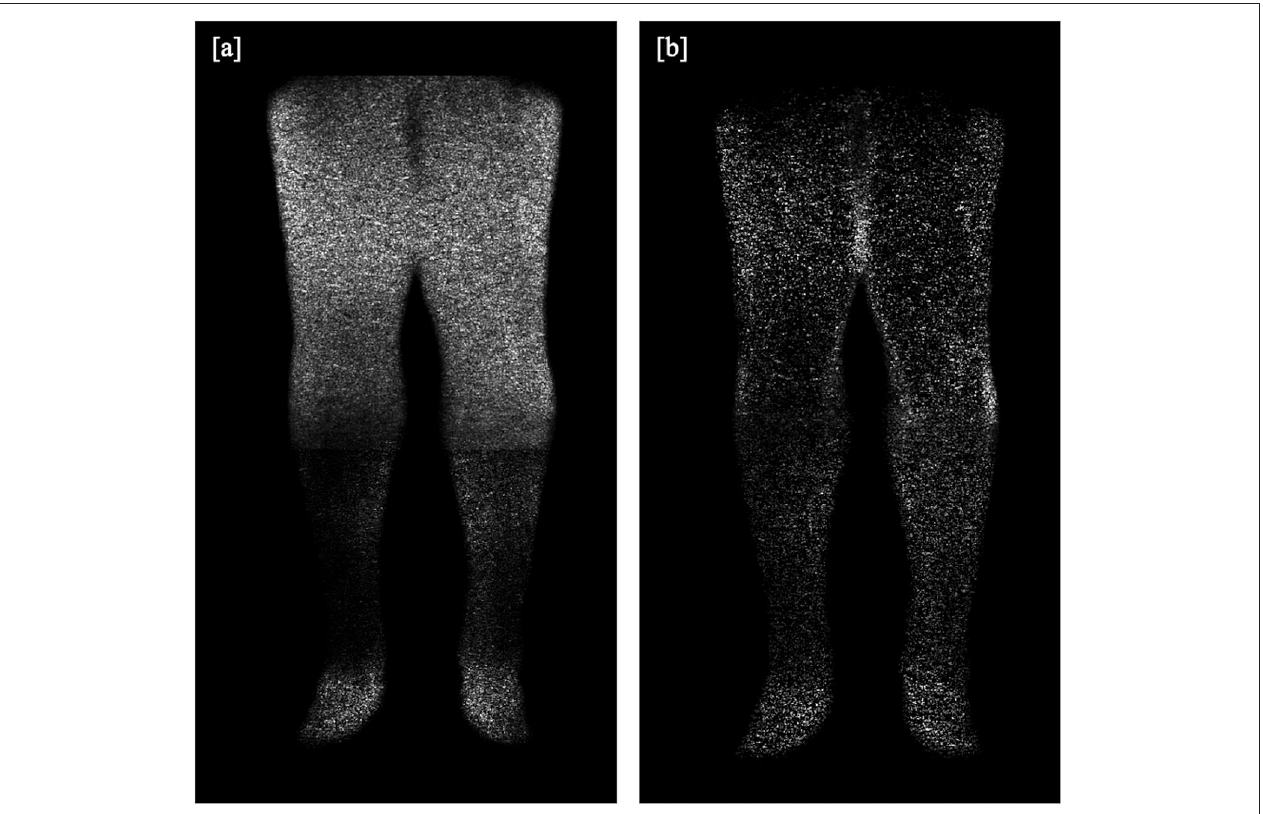
FIGURE 1 | (a,b) : Additional scan in a healthy volunteer for SNR analysis, without application of a contrast agent or radiofrequency excitation, providing (a) a subtraction image and (b) an mDixon water or fat-suppressed